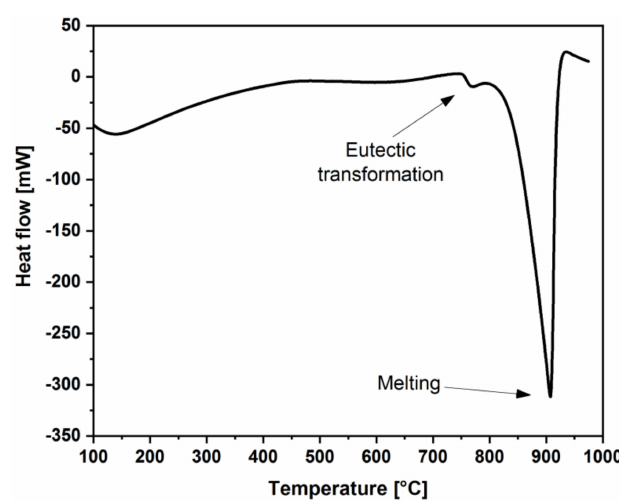
Figure 5. Di ff erential scanning calorimetry (DSC) analysis of the Ag-Cu-Ni-Zn alloy.